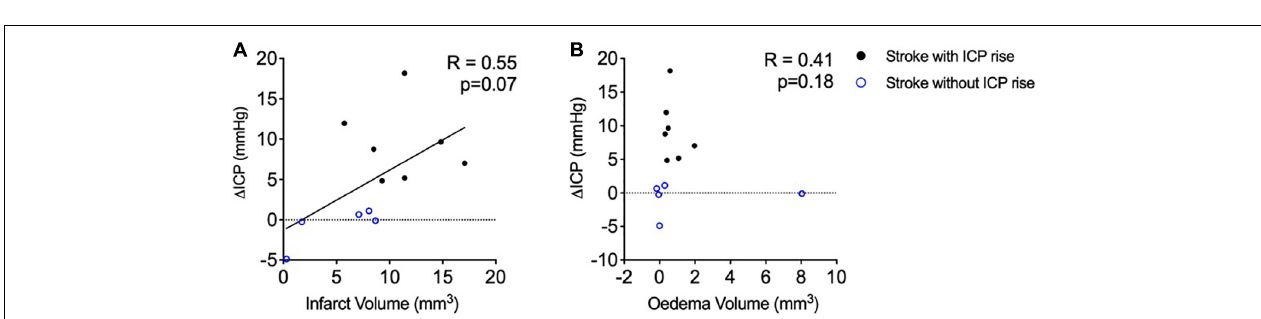
FIGURE 3 | (A) Relationship between infarct volume (mm 3 ) and intracranial pressure rise ( (cid:49) ICP; mmHg). Black closed circles represent stroke animals with an ICP rise greater than +4.4 mmHg ( n = 7) and blue open circles represent those without ICP rise ( n = 5). (B) Relationship between oedema volume (mm 3 ) and (cid:49) ICP. A Spearman correlation was used for analyses.